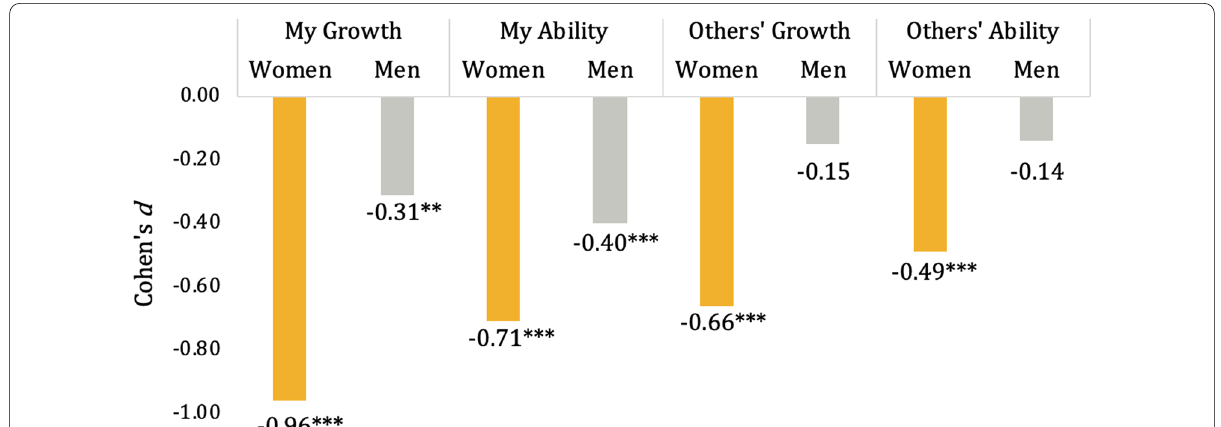
Fig. 1 Student mindset changes over time by gender/sex. We report the effect size (Cohen’s d ) between pre- and post-survey mindset scores. A negative value indicates students had lower scores at the end of the semester than at the start. * p < 0.05, ** p < 0.01, *** p < 0.001